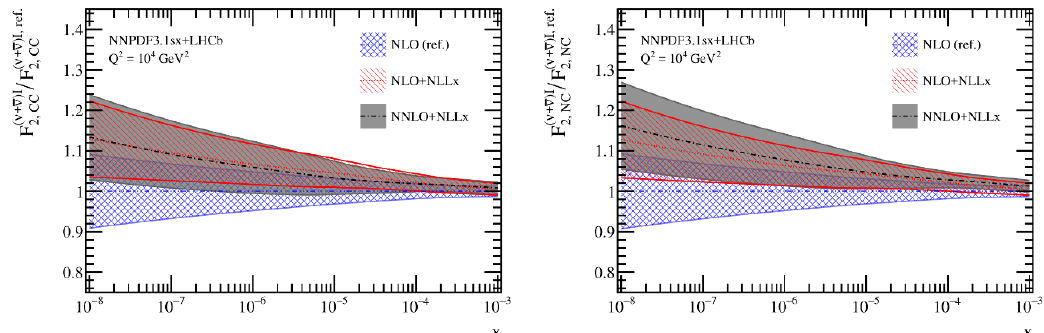
Figure 12 . The CC (left) and NC (right plot) structure function F (cid:23) +(cid:22) (cid:23) isoscalar target at Q 2 = 10 4 GeV 2 with the NNPDF3.1sx+LHCb sets for three di(cid:11)erent theoretical settings: NLO, NLO+NLL x , and NNLO+NLL x . The structure functions are normalised to the central value the NLO calculation, with the bands indicating the 1 (cid:27) PDF